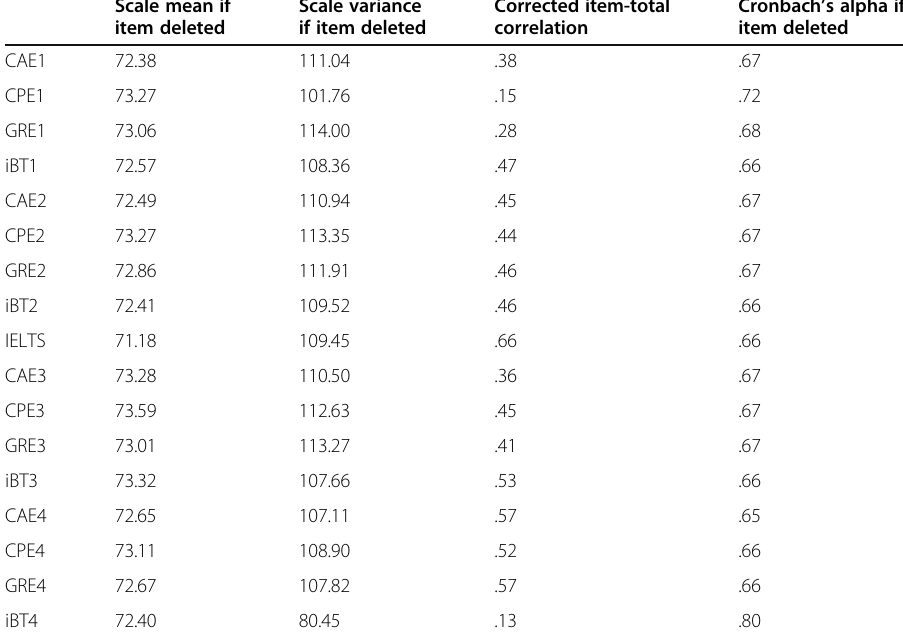
Table 4 Item-total statistics Scale mean if item deleted